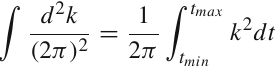
and afterwards obtained the eikonal function T(b) integrat- ing the action in the overlap area of the collision depending on the impact parameter b . The obtained eikonal for central O–O collisions T ( 0 ) is illustrated in Fig. 10 (lower